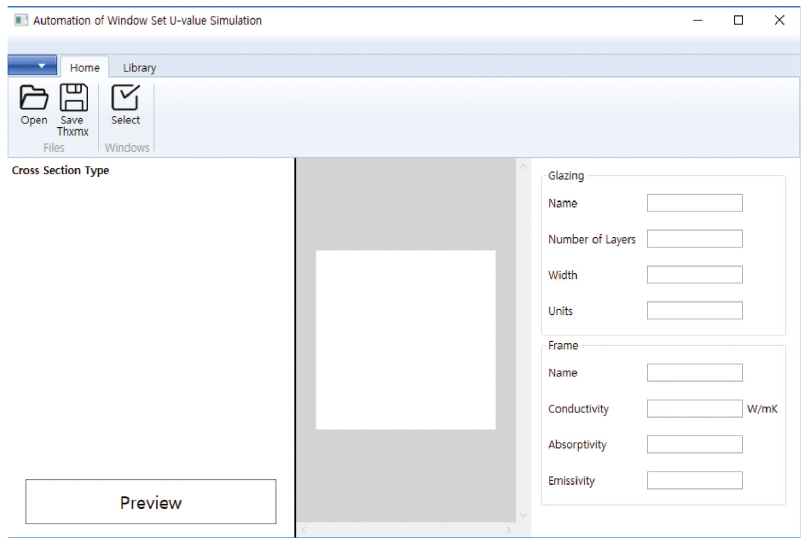
Figure 7: Graphic user interface of the developed program.